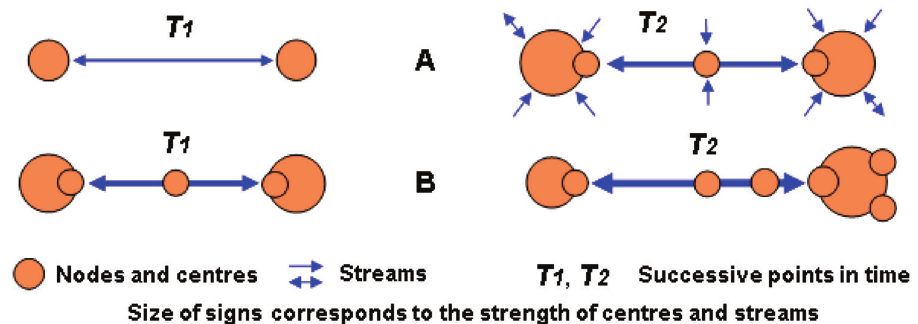
Figure 4. Two-way (A) and one-way (B) positive feedback between flows and shifts. Symbolic schemes compiled by the